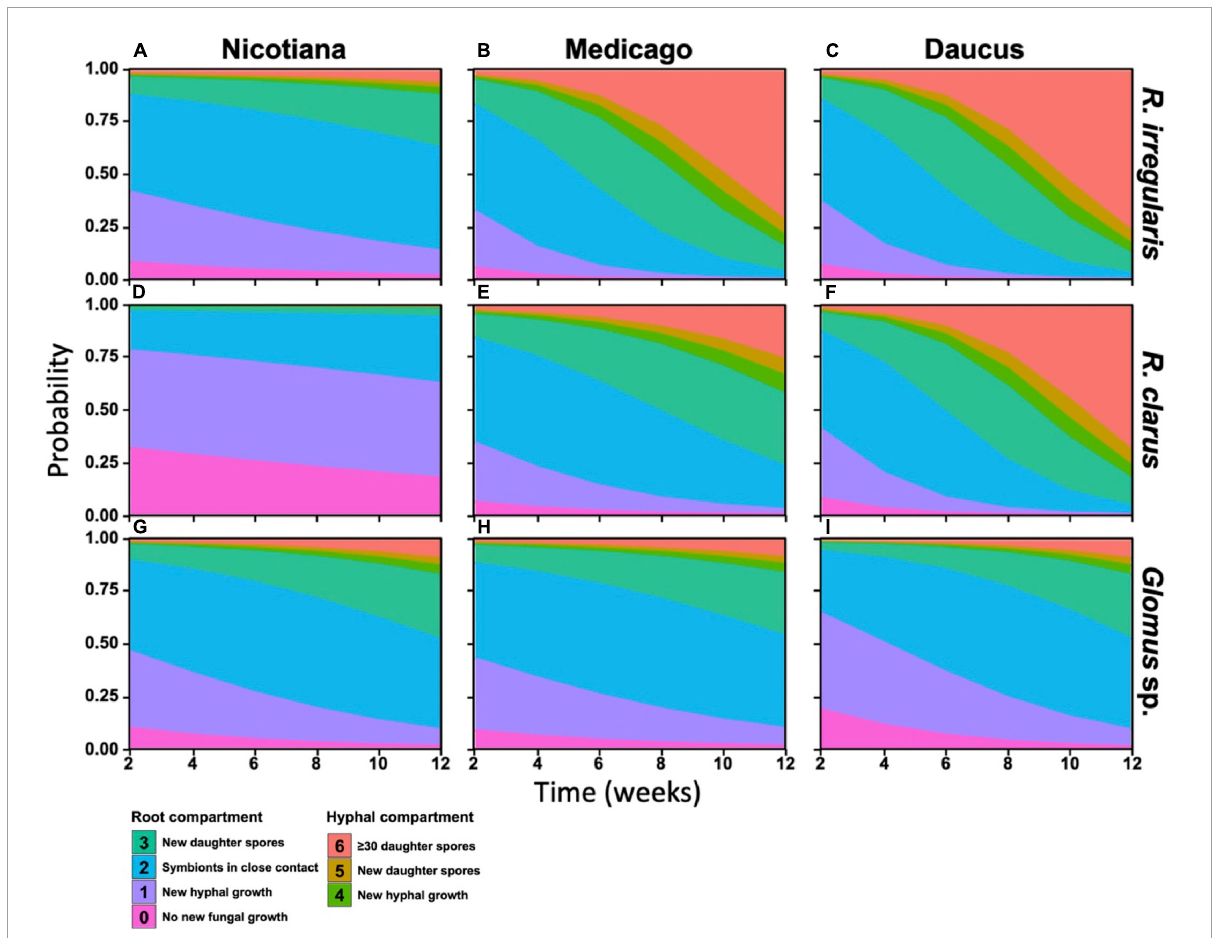
FIGURE2 Stacked probabilities of each pair of host and AM fungal species. Distribution of colored polygons correspond to the probability distribution of any pair host and AM fungus replicate reaching a developmental stage (see Figure 1C ) at any given time during the 12-week assay period. Probabilities were generated by testing fungal development as a function of a three-way interaction between host identity, fungal identity, and time (in weeks) using a multinomial linear